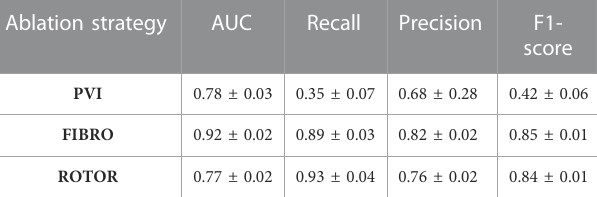
TABLE 3 Mean area under the receiver operating characteristic curve (AUC) score, recall, precision and F1-score on independent hold-out test set (with standard deviation) for each RFCA